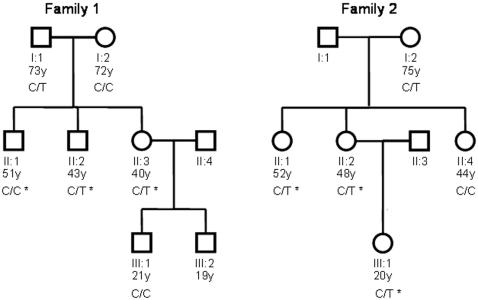
Families of the two probands with the PRKAG3-R225W mutation.*Subjects who underwent muscle biopsy.